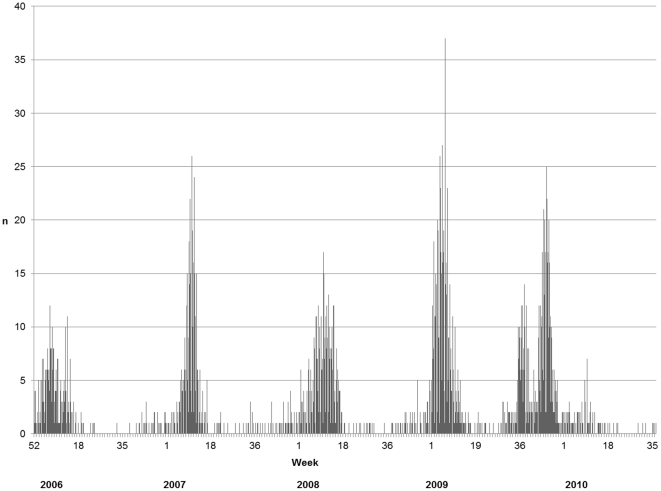
Influenza outbreaks in Östergötland county 2006–2010.Influenza cases (ICD-10 codes 10.0–11.8) per day in Östergötland county 2005–2010. The influenza activity as accumulated into five outbreaks lasting between 2006-01-01–2006-04-20 (circulating virus types B, A/H3 and H1N1), 2007-01-31–2007-04-11 (A/H3N2), 2008-01-21–2008-04-30 (B and A/H1), 2008-12-24–2009-03-30 (A/H3N2), and 2009-08-21–2009-12-22 (A pH1N1).